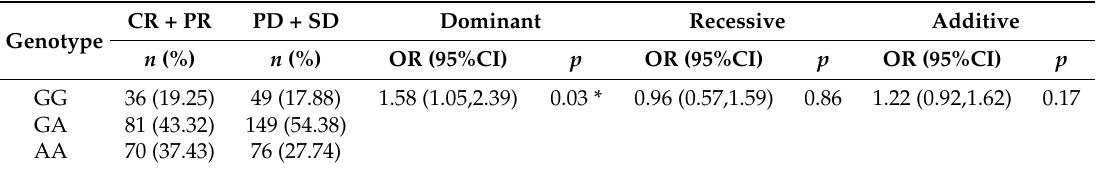
Table 5. Association between CASC8 rs10505477 and chemotherapy response in lung cancers. CR + PR Genotype